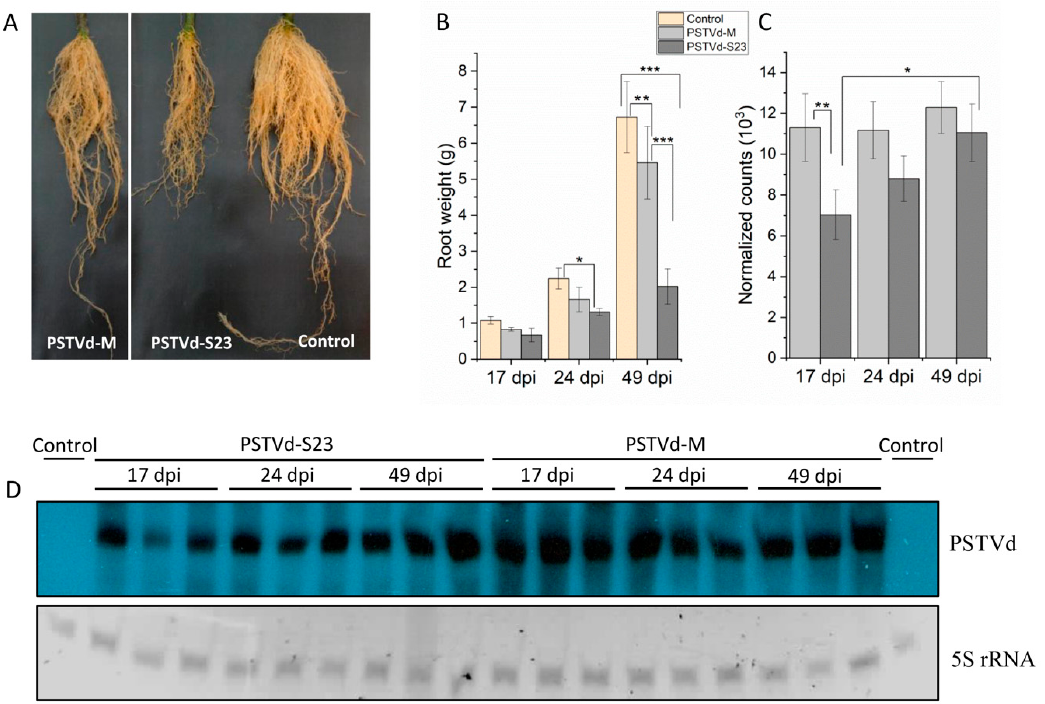
Figure 1. Potato spindle tuber viroid (PSTVd) infection in tomato roots. ( A ) Root comparison at 49 dpi. ( B ) Root weight at the indicated time points. Each bar represents the arithmetic mean of the weight of three roots with the standard deviation indicated. ( C ) Relative levels of viroid RNA as estimated using the Nanostring nCounter method and nSolver analysis software. The data is presented in arbitrary units compared to control plants. ( D ) Northern blots that show the presence of PSTVd in infected roots at the indicated time points. Two µg total RNA were separated in 5% polyacrylamide gel with 8 M urea. One-way analysis of variance followed by Tukey’s honest significant difference test was used to determine statistically significant differences. * p < 0.05; ** p < 0.01; *** p < 0.001.